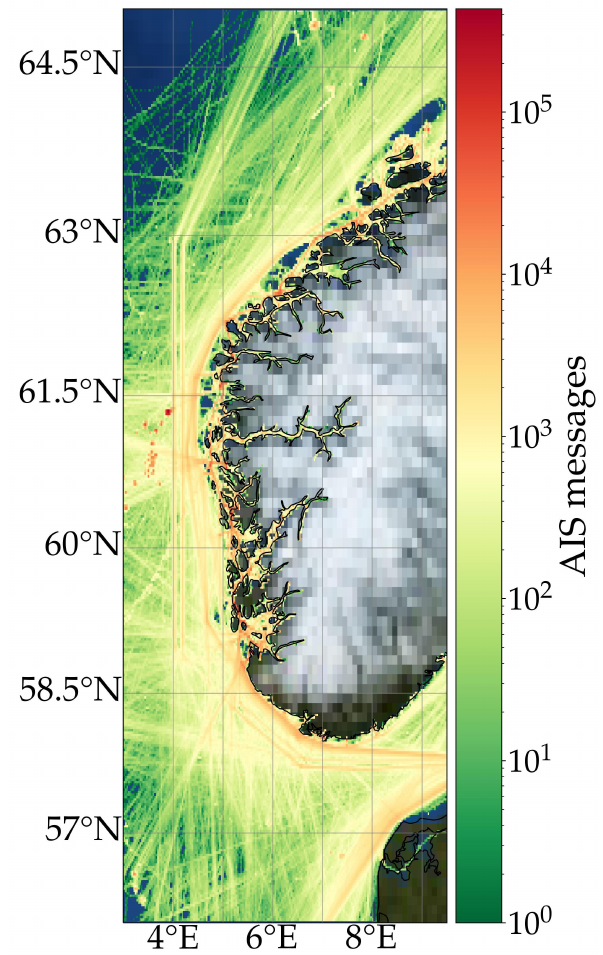
Figure 3. Heatmap of pre-processed cargo ship AIS data near Norway with high density correspond- ing to red colours. The red lines corresponds to the most used sea lanes. The red dots northeast of Norway corresponds to, e.g., oil